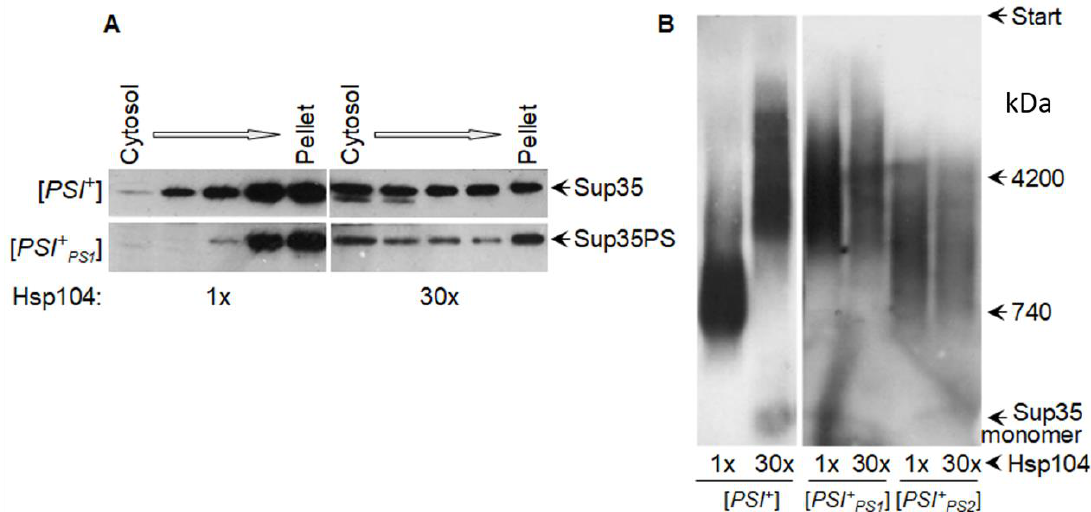
Figure 5. Overproduced Hsp104 disassembles Sup35 prion aggregates, but not fibrils. Hsp104 was either endogenous, or produced from a multicopy plasmid under control of the native promoter (~30-fold excess). ( A ) Sup35 aggregates of yeast lysates fractionated by centrifugation. Sup35PS, [ PSI + PS1 ], and [ PSI + PS2 ] relate to Sup35 with prion domain from yeast P. methanolica and M and C domains from S. cerevisiae and its two prion variants. ( B ) SDD-AGE of Sup35 prion fibrils. ( A , B ) Western blot staining for Sup35NM. Data reproduced from previous research [107] ( A ), [44] ( B